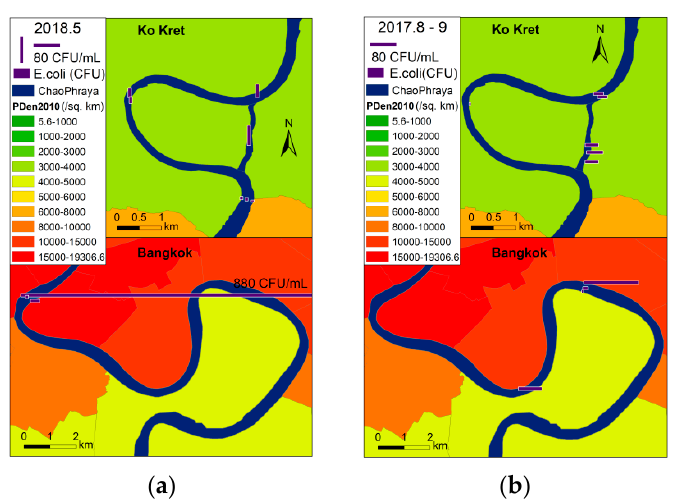
Figure 11. The zoomed-in view of E. coli distribution along the two river bends. ( a ) At the beginning of the wet season; ( b ) In the second half of the wet season.